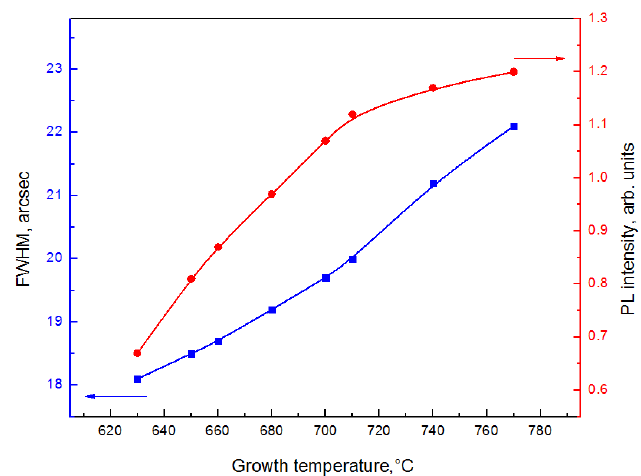
Figure 4. FWHM of the X-ray satellite peaks and intensity of photoluminescence between levels in the conduction and valence bands as functions of growth temperature.